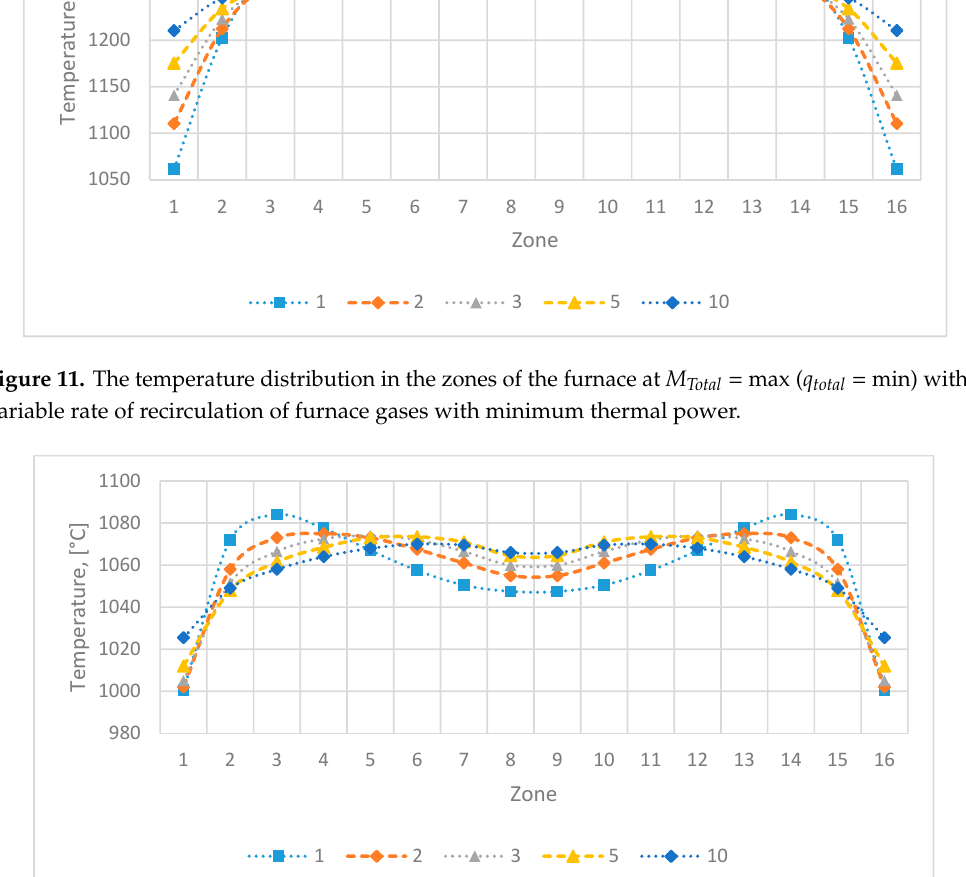
Figure 12. The temperature distribution in the zones of the furnace at M Total = min with a variable rate of recirculation of furnace gases with minimum thermal power.